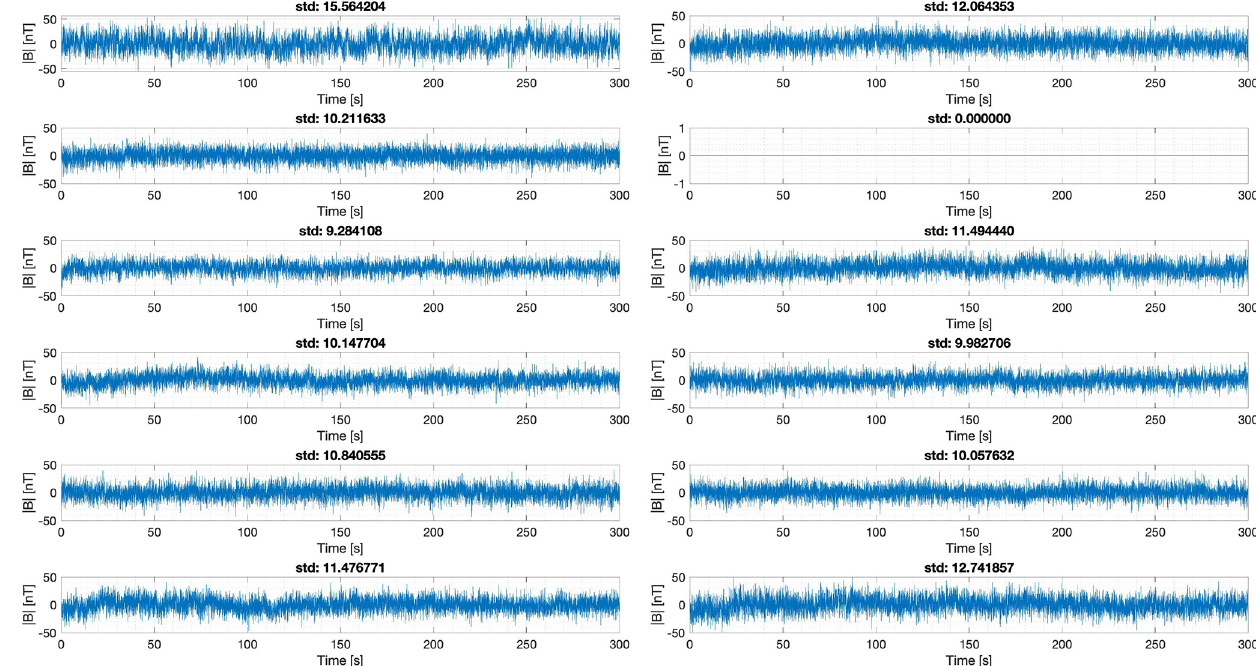
Figure 10. Pre- and post-exposure (left and right panels, respectively) measurements of the magnetic field inside the zero-Gauss chamber at the University of Michigan for the six sensors used during the GSFC test